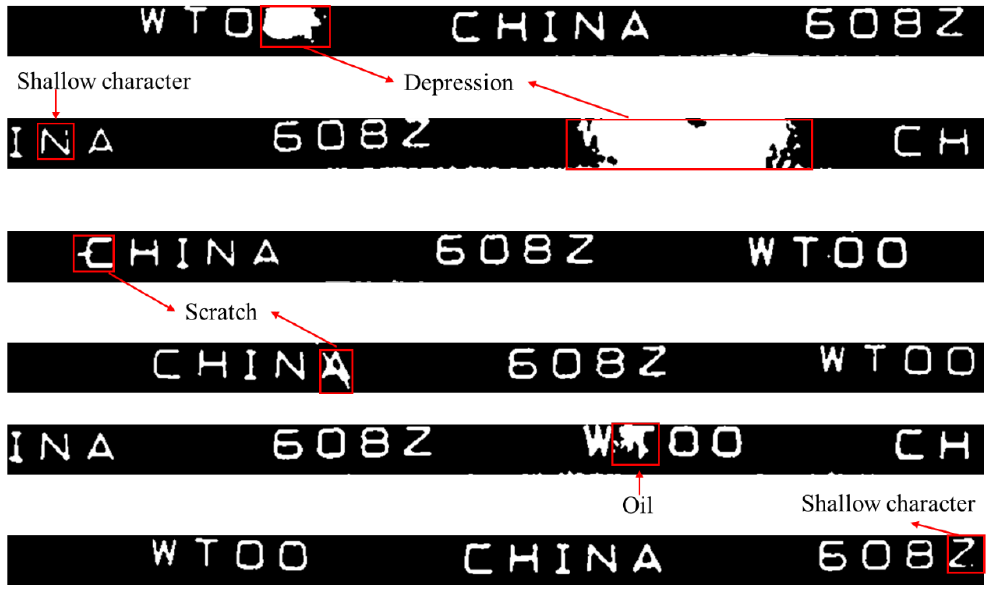
Figure 19. Character defects on the dust